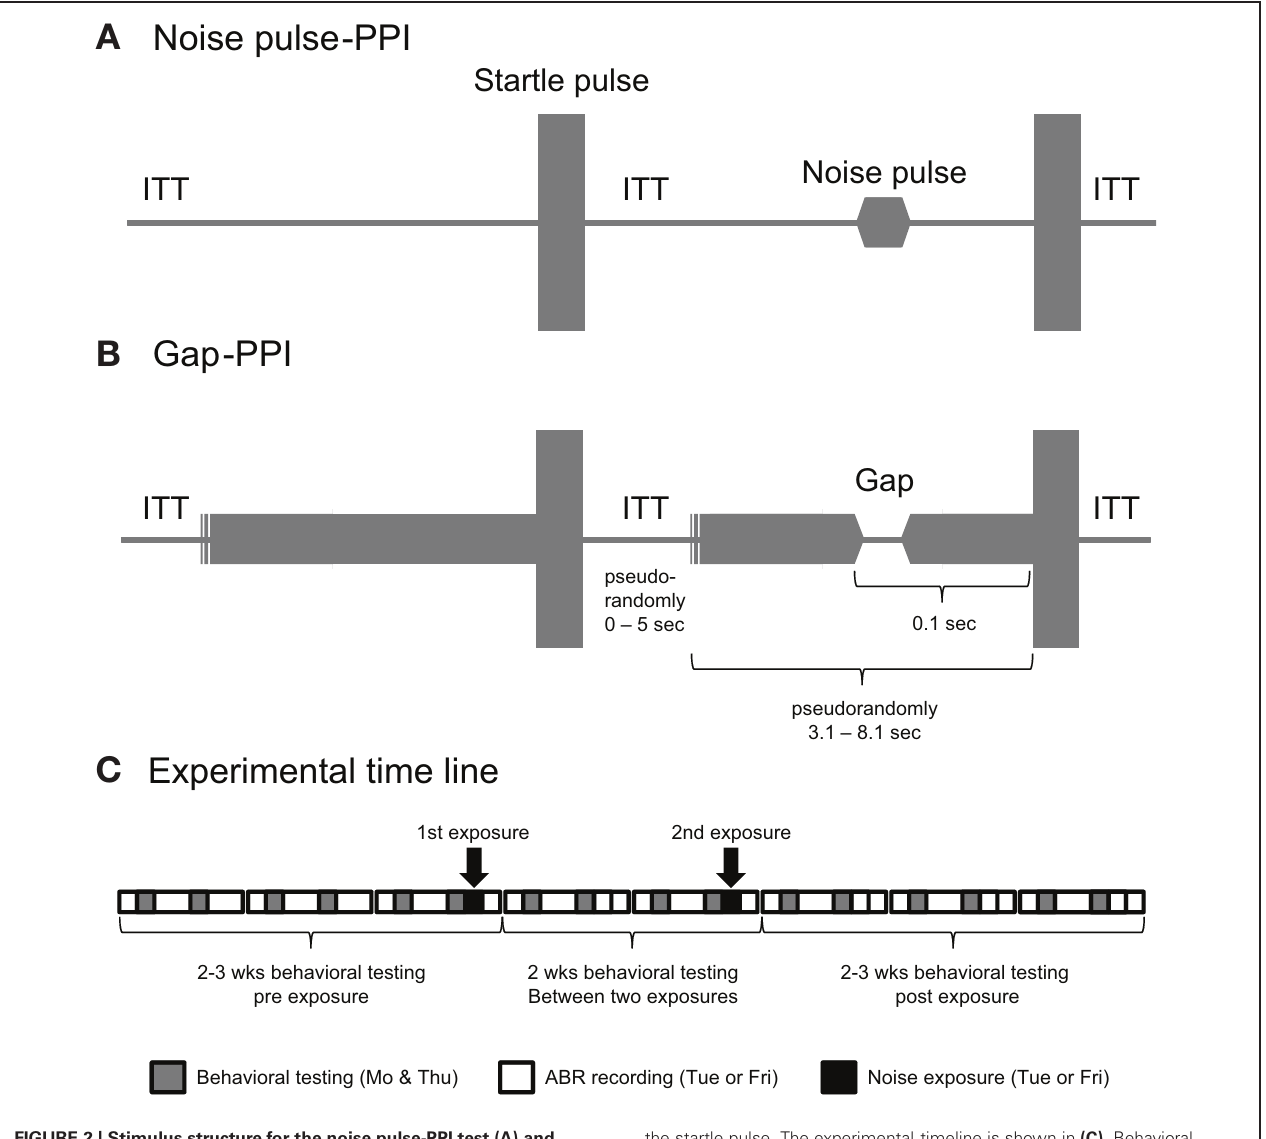
the startle pulse. The experimental timeline is shown in (C) . Behavioral testing was done throughout the experiment, including 2–3 weeks before the first, and 2–3 weeks after the last exposure. Note that two of the 11 animals tested received only one noise exposure. The exposures and ABRs were done either on Tuesdays or Fridays for a certain animal; in the example shown in the (C) they were done on